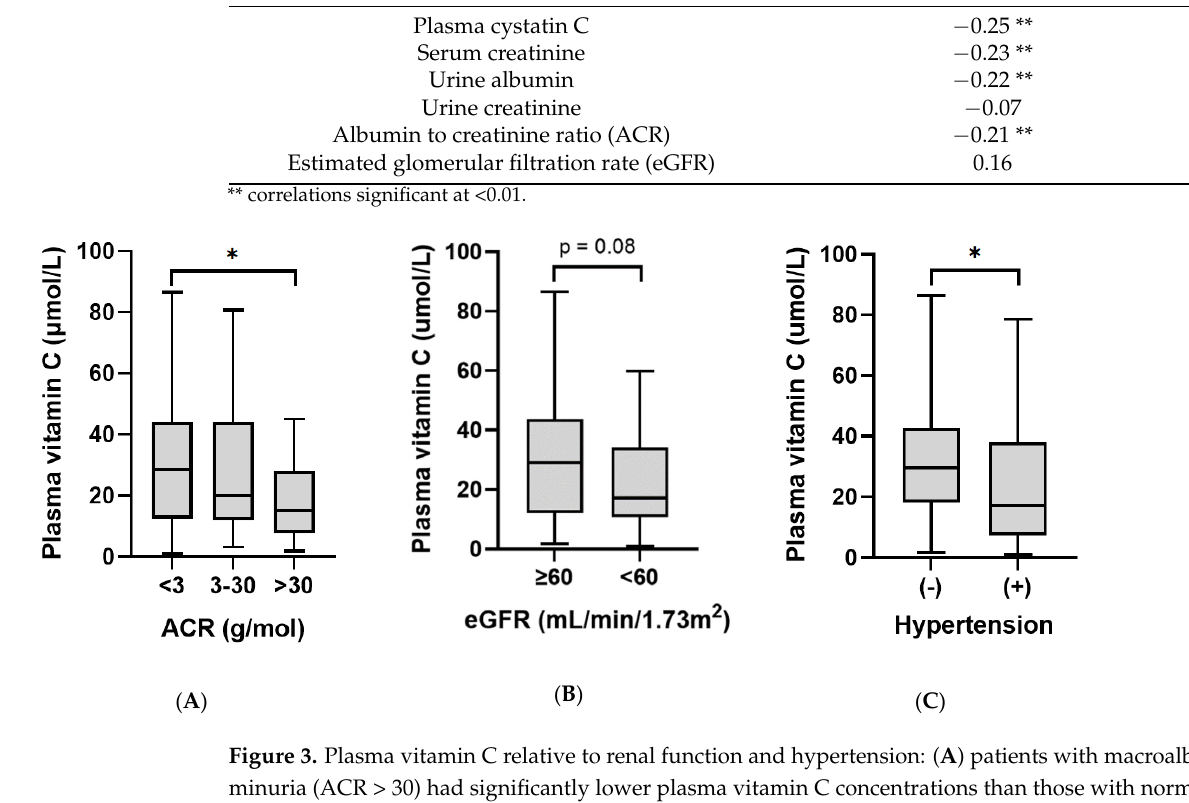
Figure 3. Plasma vitamin C relative to renal function and hypertension: ( A ) patients with macroal- buminuria (ACR >30) had significantly lower plasma vitamin C concentrations than those with nor- mal renal function (ACR <3; * p = 0.03). ( B ) Patients with eGFR <60 had comparable plasma vitamin C concentrations to those with eGFR ≥ 60 ( p = 0.08). ( C ) Patients with treated hypertension (+) had lower vitamin C status than those without ( − ) (* p = 0.01).